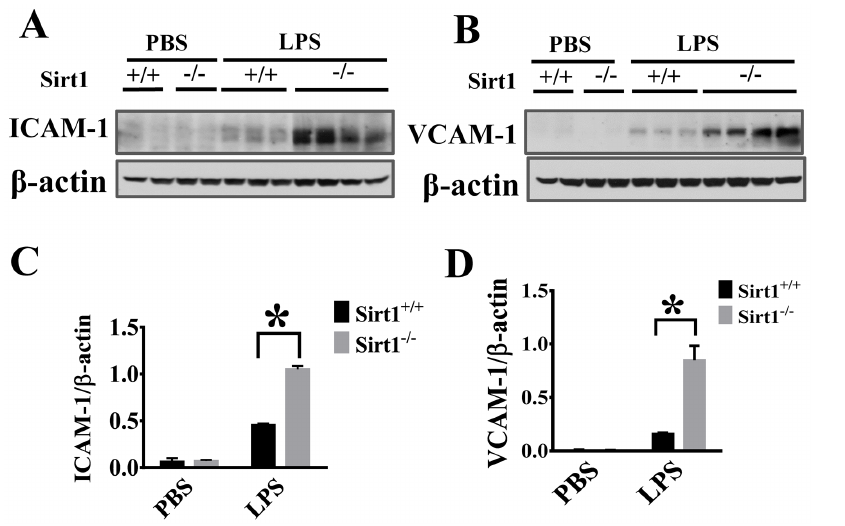
Figure 5. Sirt1 deletion enhances LPS-induced ICAM-1/VCAM-1 expression in the kidney. ICAM-1 and VCAM-1expression were assayed 24 h after LPS challenge (n $ 4 mice/group). (A, B) Representative blots showing ICAM-1 and VCAM-1 expression in the kidney. (C, D) Densitometry